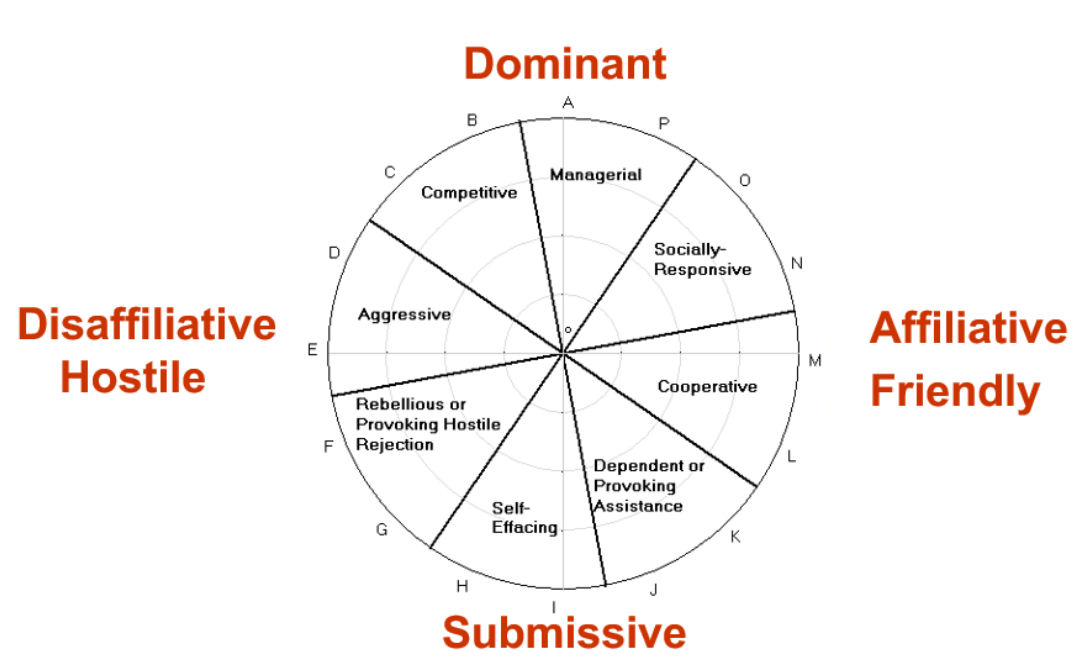
Figure 1: Interpersonal Check List Chart showing Axes and